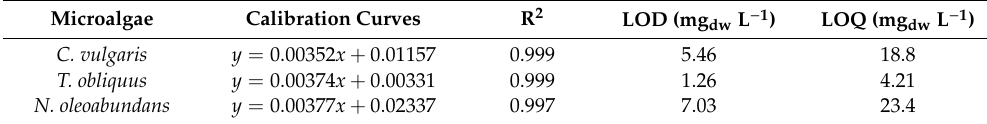
Table 1. Calibration curves of OD 680 and biomass concentration in terms of dry weight.